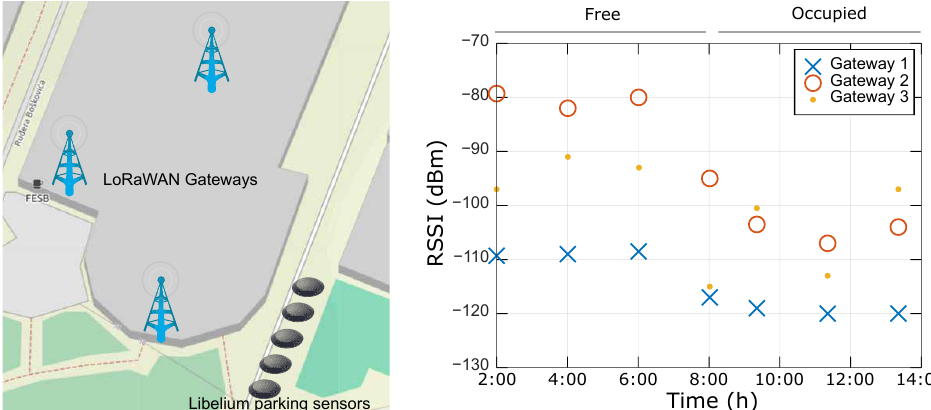
Figure 2. ( left ) Three LoRaWAN Gateways in the close vicinity of Libelium slart parking sensors, ( right ) Received Signal Strength Indicator (RSSI) captured on three LoRaWAN gateways from one Libelium Parking sensor